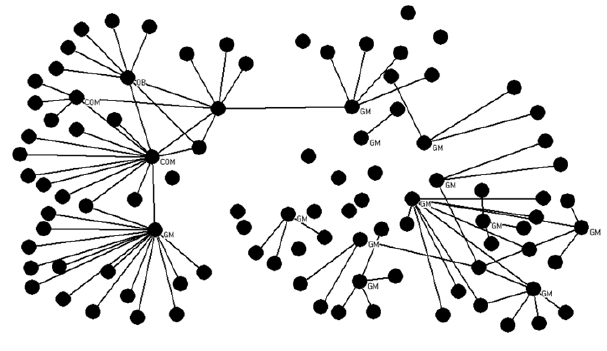
Fig. 12 . Fragmentation of Landcare Group B based on ‘what-if’